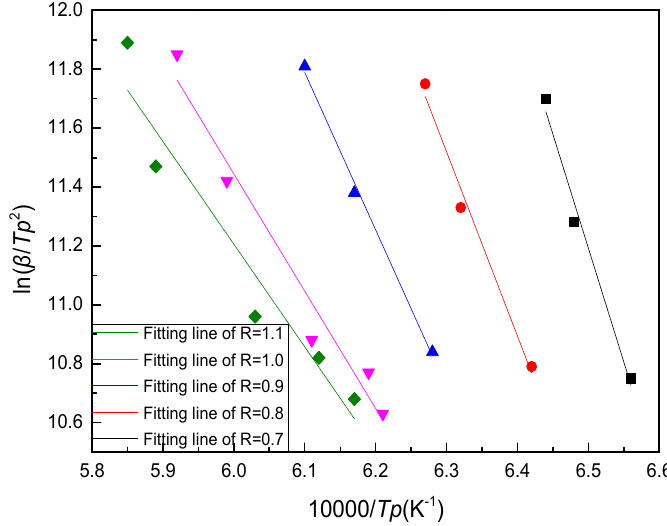
Figure 7. Crystallization activation energy ( Ec ) calculated using the Kissinger method. Table 4. Crystallization activation energy ( Ec ) calculated using different methods/(kJ/mol).